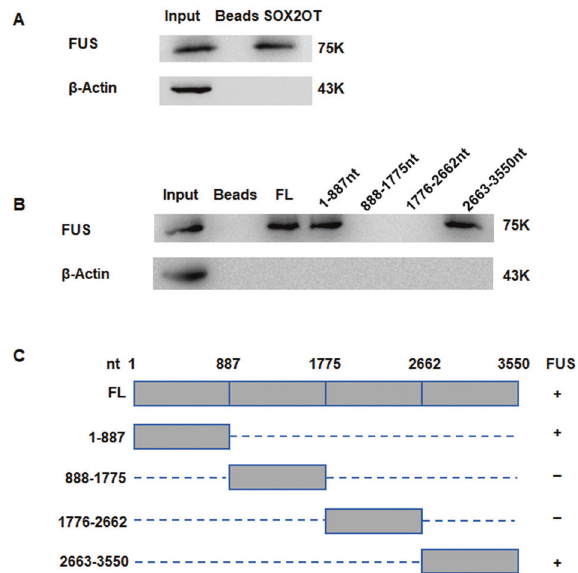
Fig. 3 SOX2OT binds directly to FUS protein through its 1 – 887 nt and 2663 – 3550 nt sequence. A RNA pull-down assay followed by western blot con fi rmed FUS as a protein partner binding speci fi cally to SOX2OT. β -Actin is protein controls. B Western blot of FUS pulled- down by truncated SOX2OT fragments. This analysis revealed that nucleotides 1 – 887 and 2663 – 3550 of SOX2OT (SOX2OT 1 – 887 nt, SOX2OT 2663 – 3550 nt) are suf fi cient to interact with FUS protein, while other SOX2OT truncated fragments could not. FL full length. C Schematic of truncated or deletion mutants of SOX2OT. The FUS binding capability is shown (right).